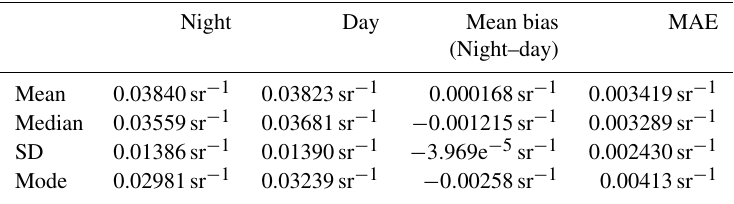
Table 1. Mean, median, mode, and standard deviation of the day and night iATB distributions of rapidly attenuating, opaque cirrus clouds from all V3-00 CATS data. The mean bias and mean absolute error (MAE) were also calculated between the day and night